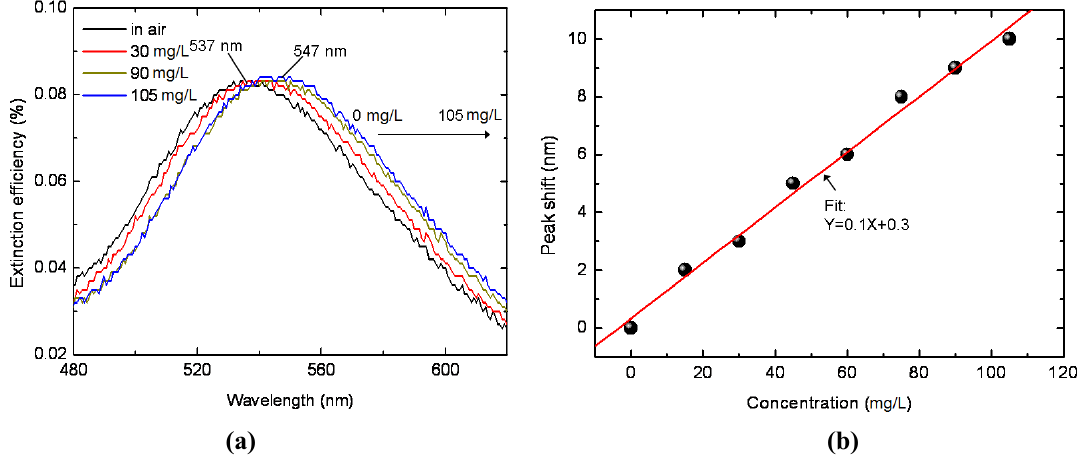
Figure 3. (a) LSPR spectra response to different ethanol vapor concentrations. (b) Response sensitivity of LSPR spectrum calibrated with eight different ethanol vapor